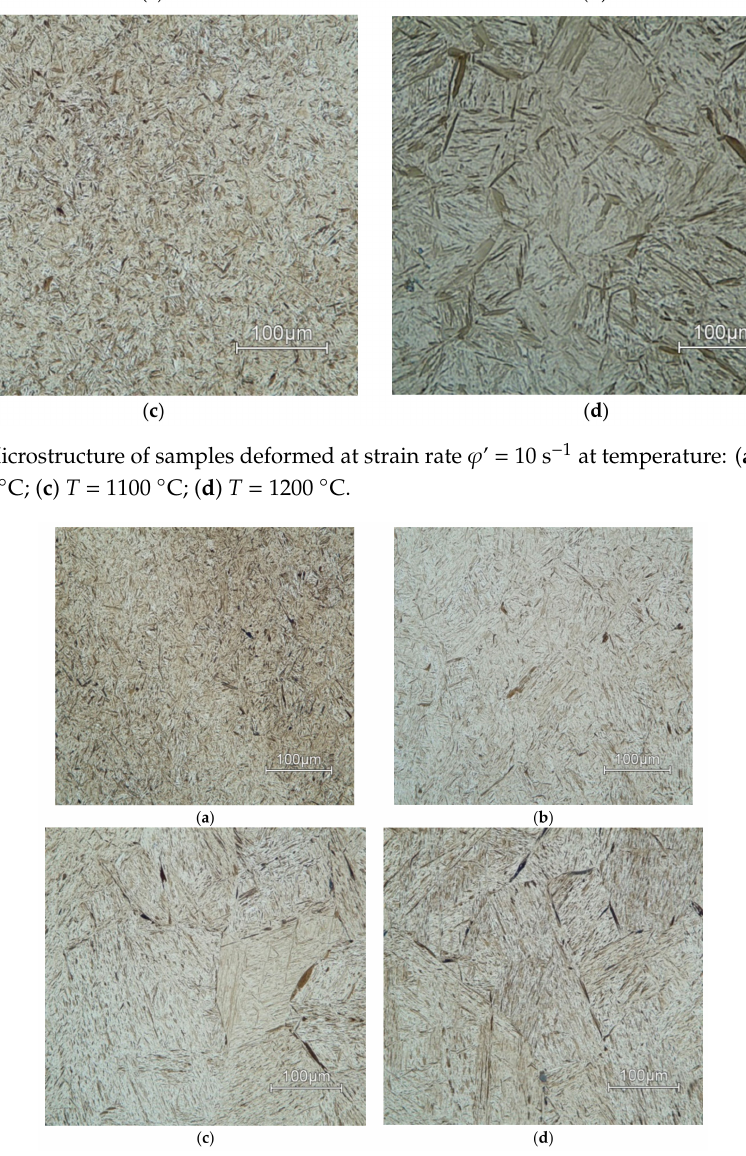
Figure 16. Microstructure of samples deformed at strain rate ϕ ´ = 0.001 s − 1 at temperature of: ( a ) T = 900 ◦ C; ( b ) T = 1000 ◦ C; ( c ) T = 1100 ◦ C; ( d ) T = 1200 ◦